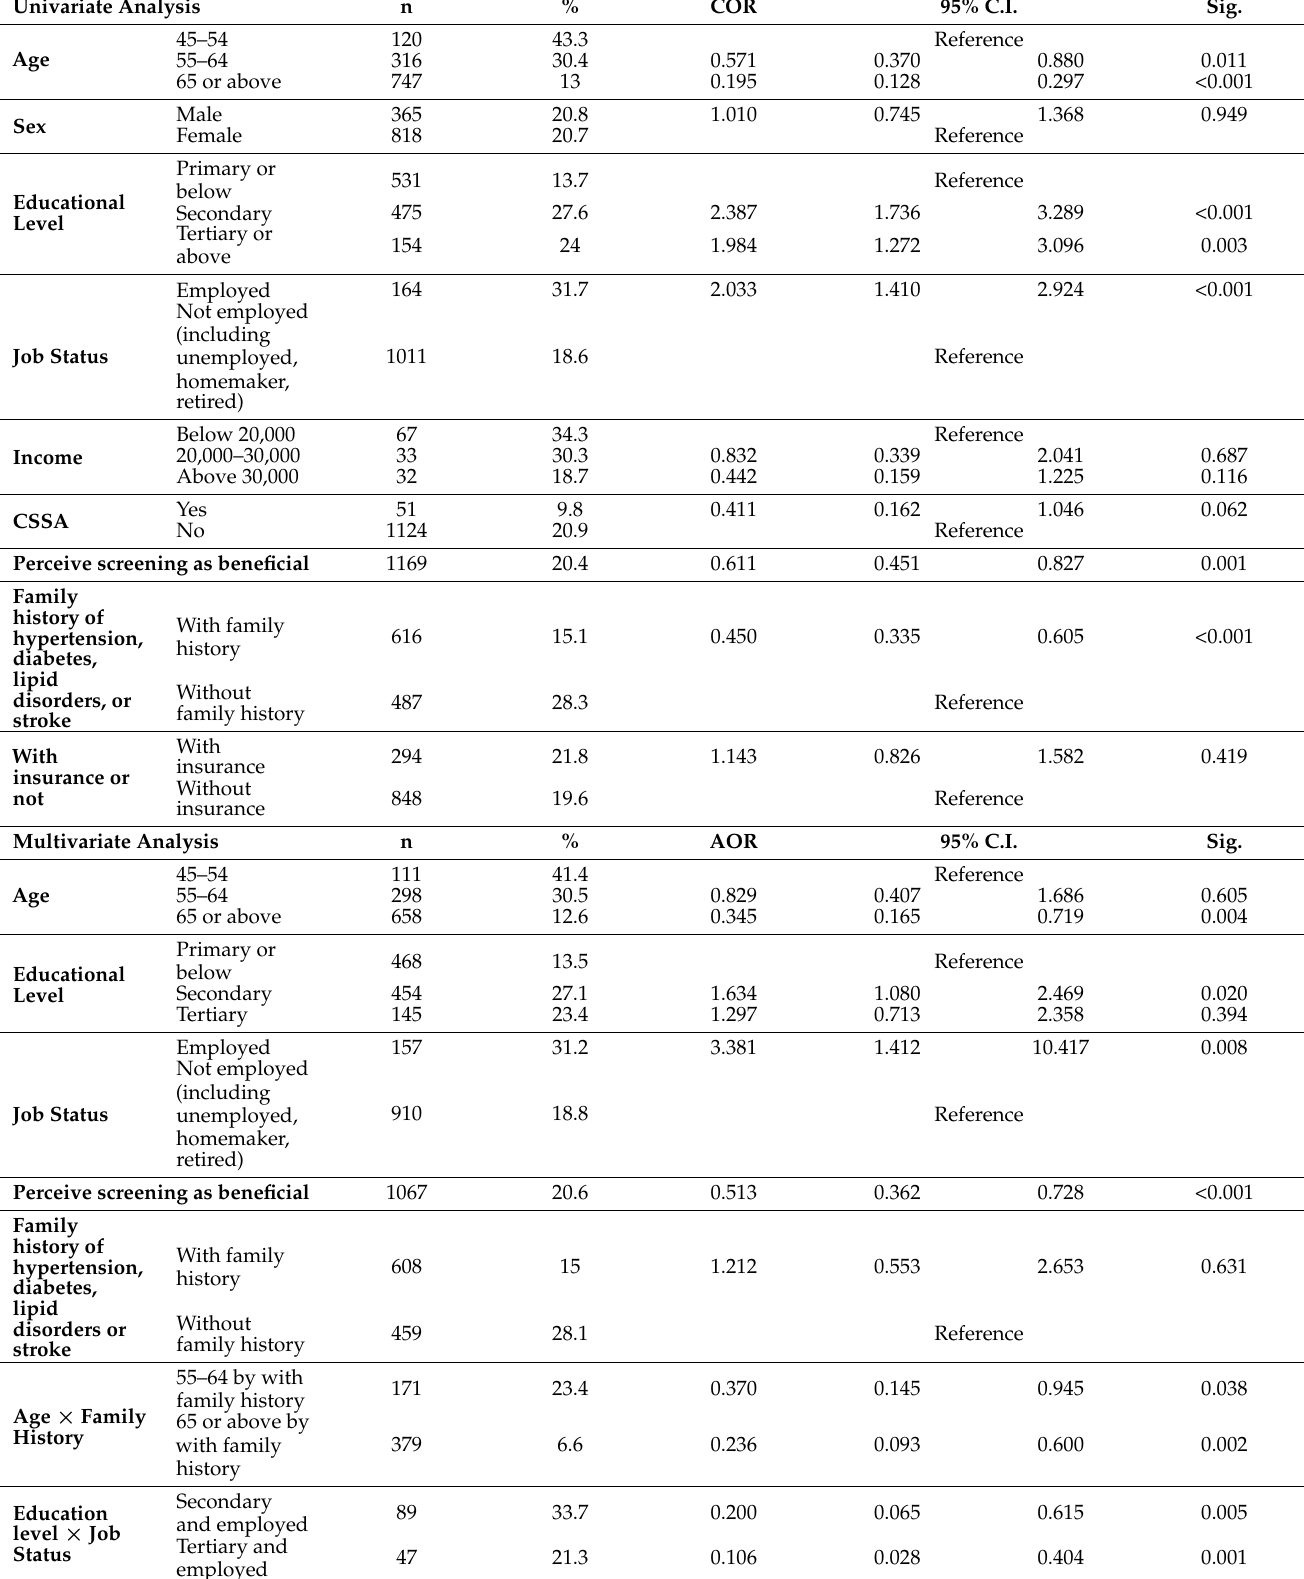
Table 4. Factors associated with not screening for all three